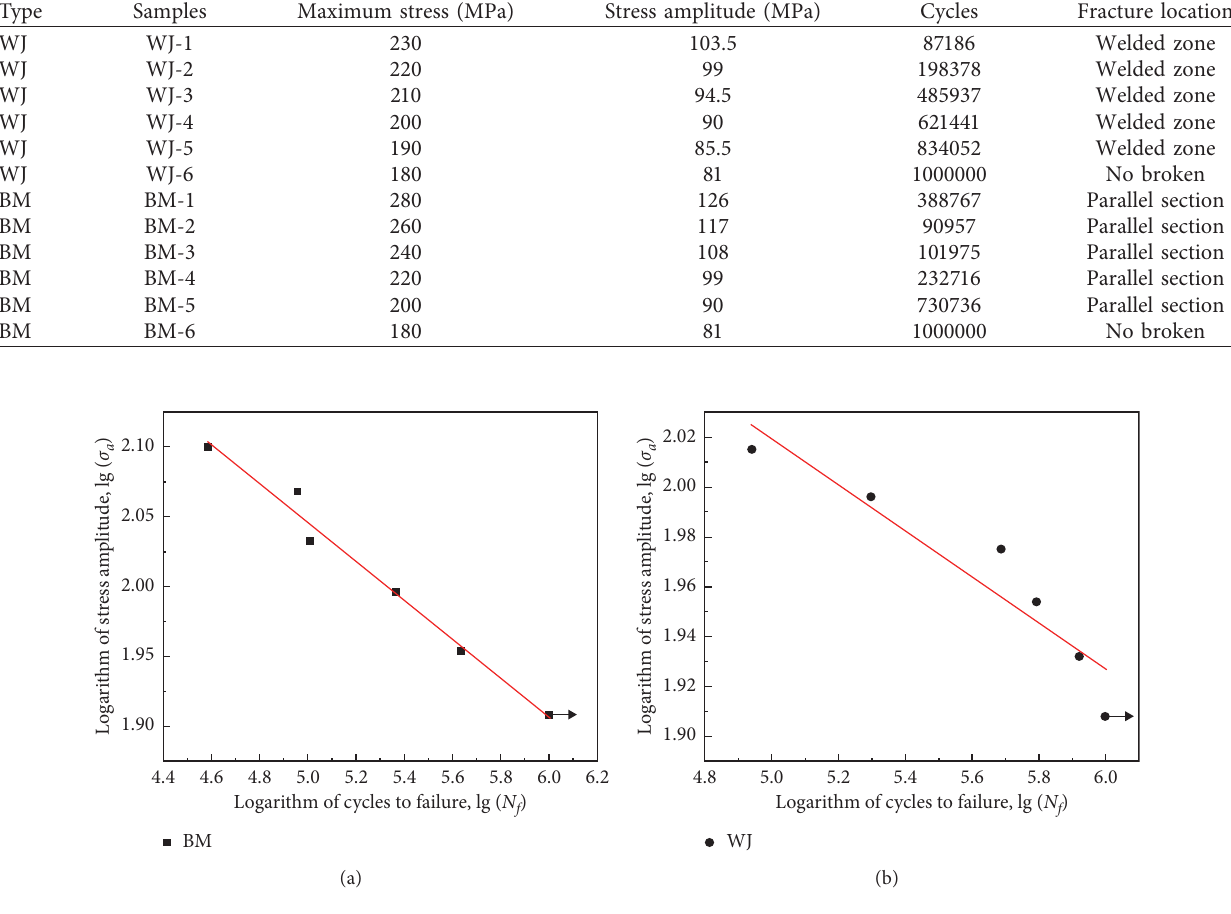
Figure 6: S-N fitting curve of (a) BM and (b) WJ.